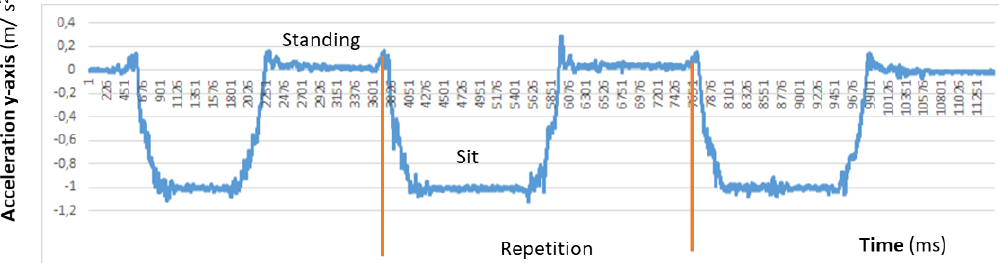
Figure 5. Acceleration in the Y -axis direction during the legs strength test.